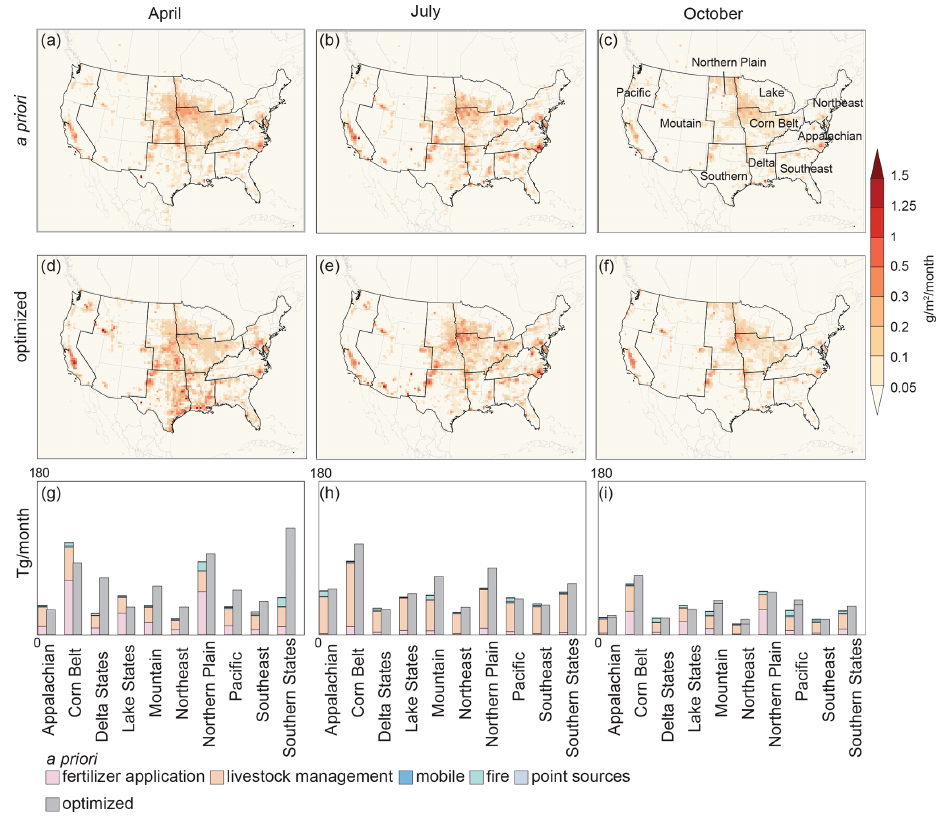
Figure 3. The spatial distribution of monthly total NH 3 emission from the a priori (a, b, c) and optimized (d, e, f) estimates in April, July, and October. The total emission based on the a priori and optimized estimates is summarized for each USDA farm production region (g, h, i) . The source contributions to total emission are shown for the a priori